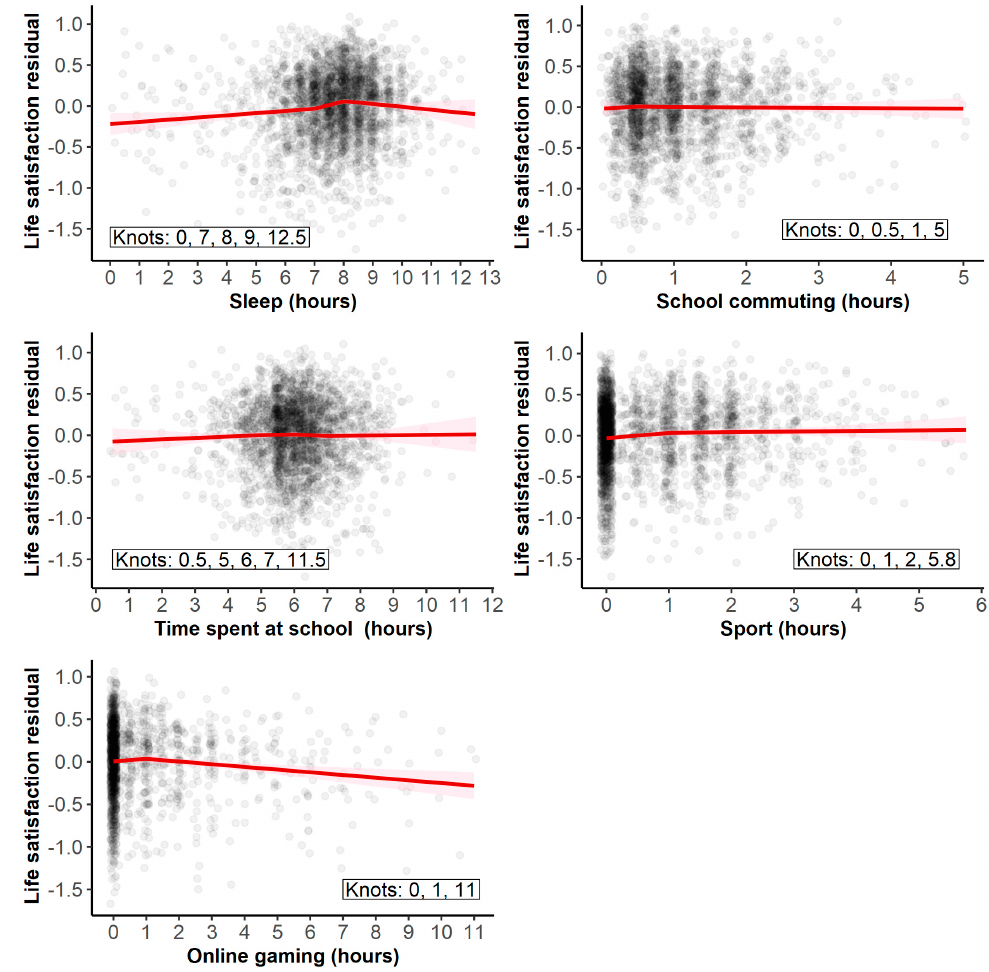
Figure 2. Effect of sleep, school commuting, time spent in school, sports, and gaming duration on life satisfaction. Note. The Y -axis shows the life satisfaction residuals, controlling for the effect of the cohort, gender, age, and parents’ income. The pink shaded regions indicate 95% confidence intervals for the fitted lines.